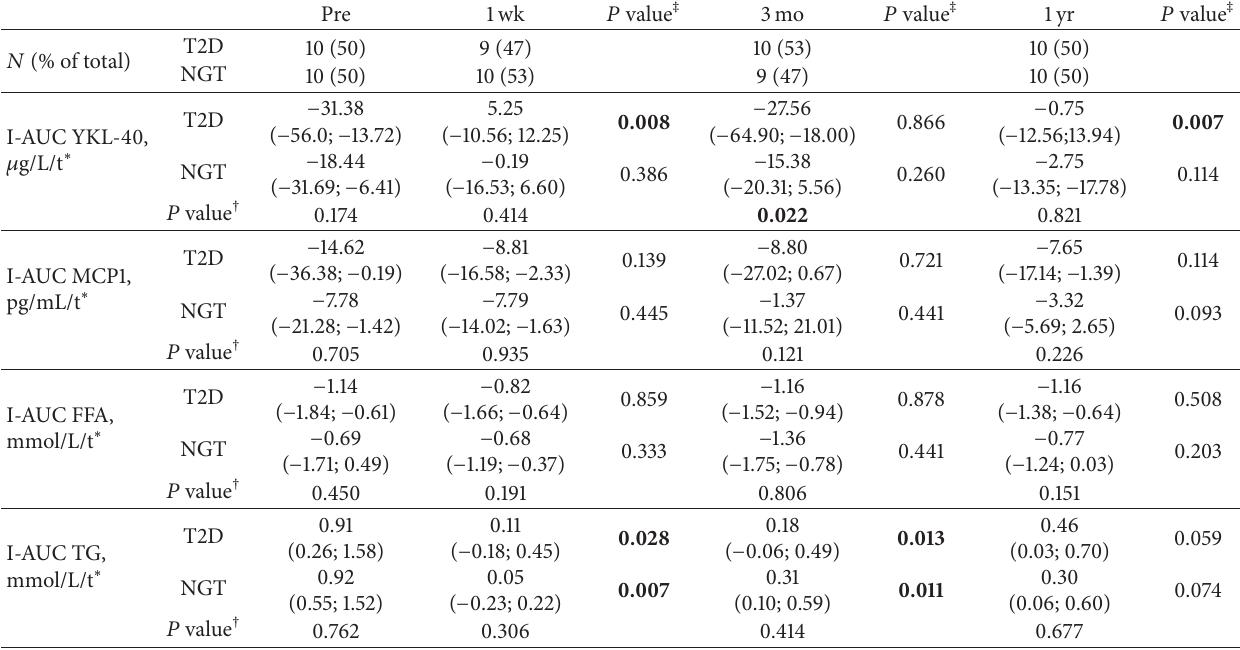
Table 2: I-AUC values for postprandial concentrations of YKL-40, MCP-1, FFA, and triglycerides in subjects with type 2 diabetes and normal glucose tolerance before (pre) and 1 wk, 3 mo, and 1yr after Roux-en-Y gastric